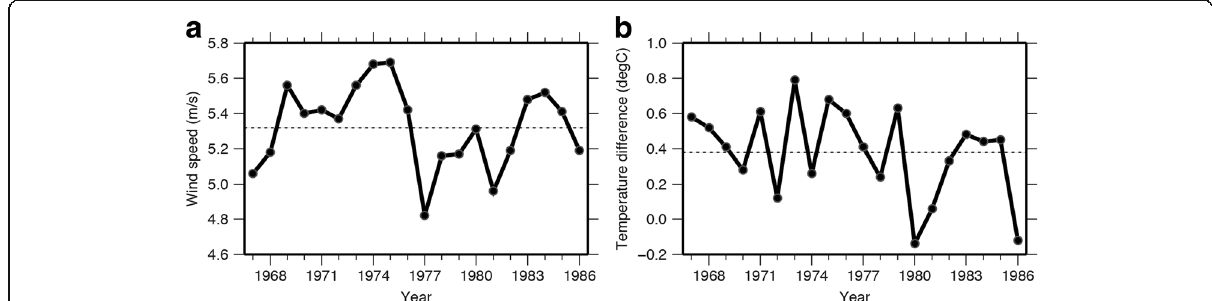
Fig. 17 Time series of wind and difference of temperature used as input to the historical simulation. Values are averaged from October to April for a the absolute wind speed and b the difference of temperature between sea surface and atmosphere. The values from October to December are grouped with the following year. Broken lines represent average values computed over 1967 to 1986